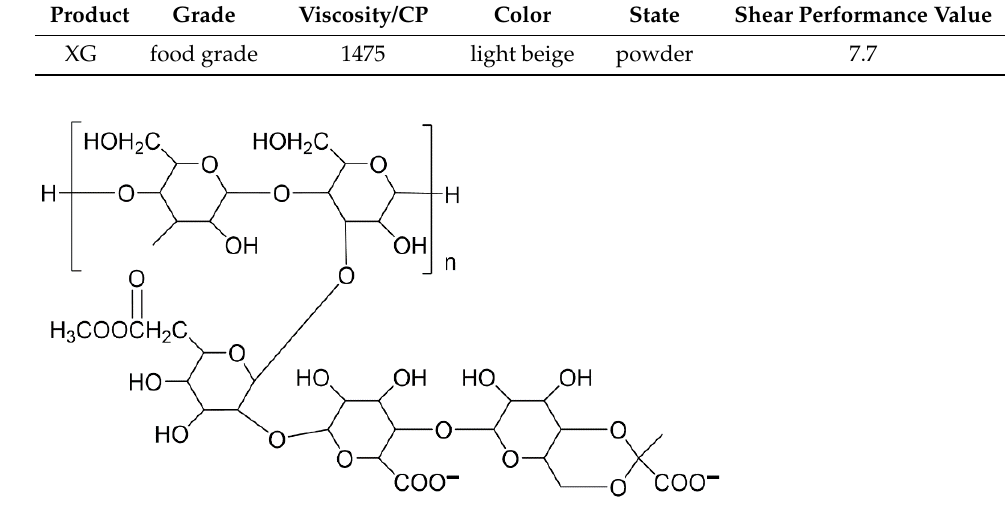
Figure 4. Molecular structure of xanthan gum. Table 2. Basic physical properties of xanthan gum.